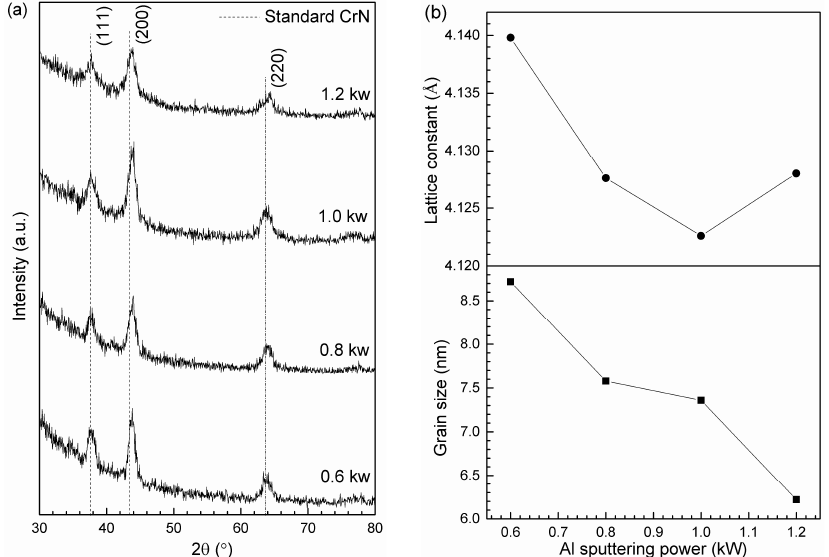
Figure 2. ( a ) XRD patterns of the four CrAlSiN coatings; ( b ) lattice constants and grain sizes calculated from (200) diffraction peaks in ( a ).